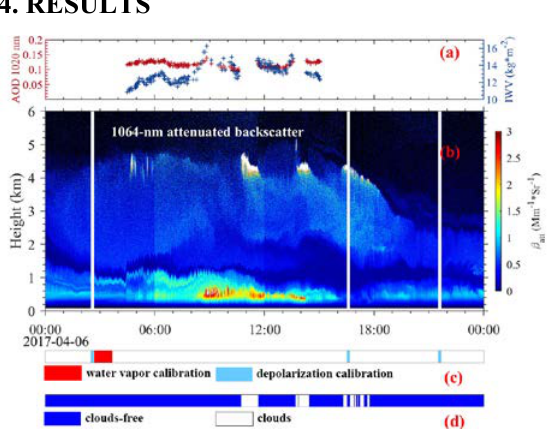
Figure 2. Dust case on 6 April 2017 at Limassol, Cyprus. (a) Level 1.5 data from AERONET (red: 1020 nm AOD, blue: IWV), (b) height-time plot of 1064 nm attenuated backscatter with Polly XT and (c) calibration and cloud status for each